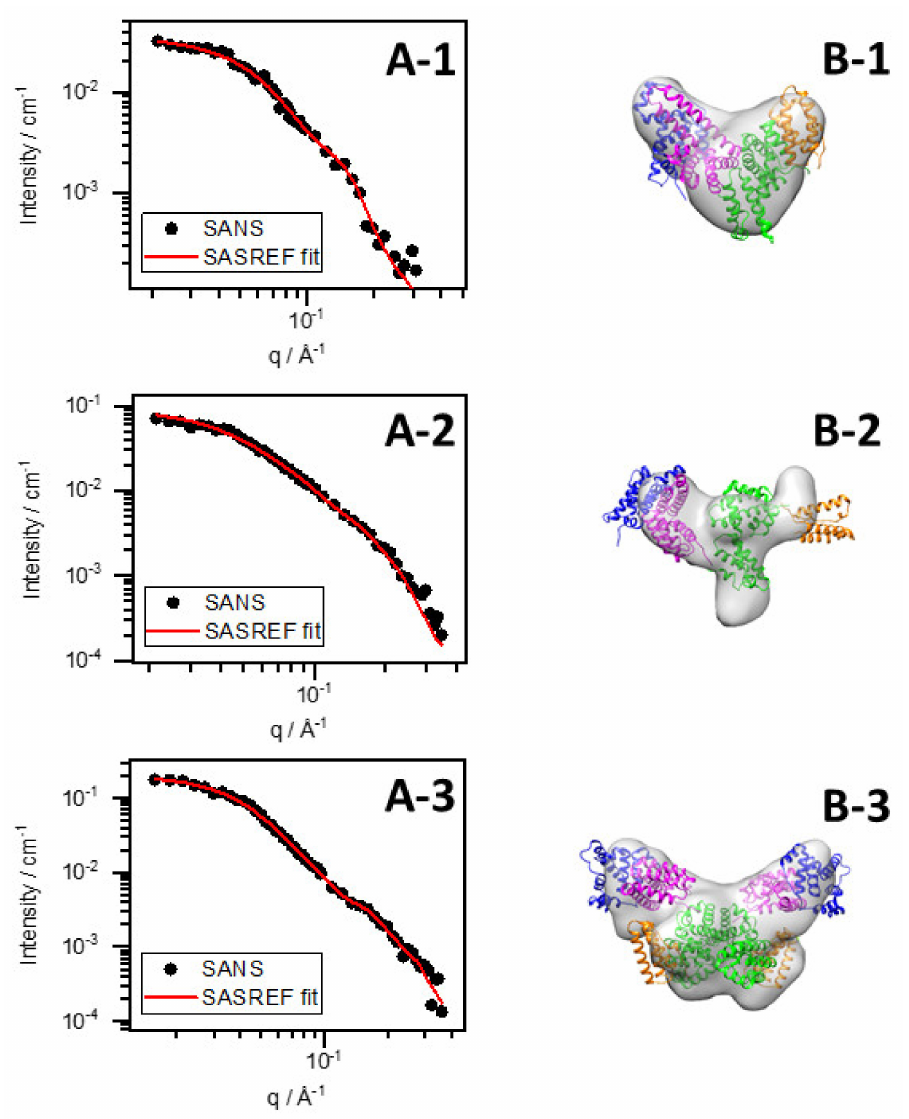
Figure 5. SANS curve of native BSA at pD ~7 and SASREF fit ( A-1 ), SANS curve of BSA–Au conjugates at pD ~12 and SASREF fit ( A-2 ), SANS curve of BSA–Au at pD ~7 and SASREF fit ( A-3 ), obtained SASREF (cartoon) and DAMMIF (surface) structures ( B-1 – B-3